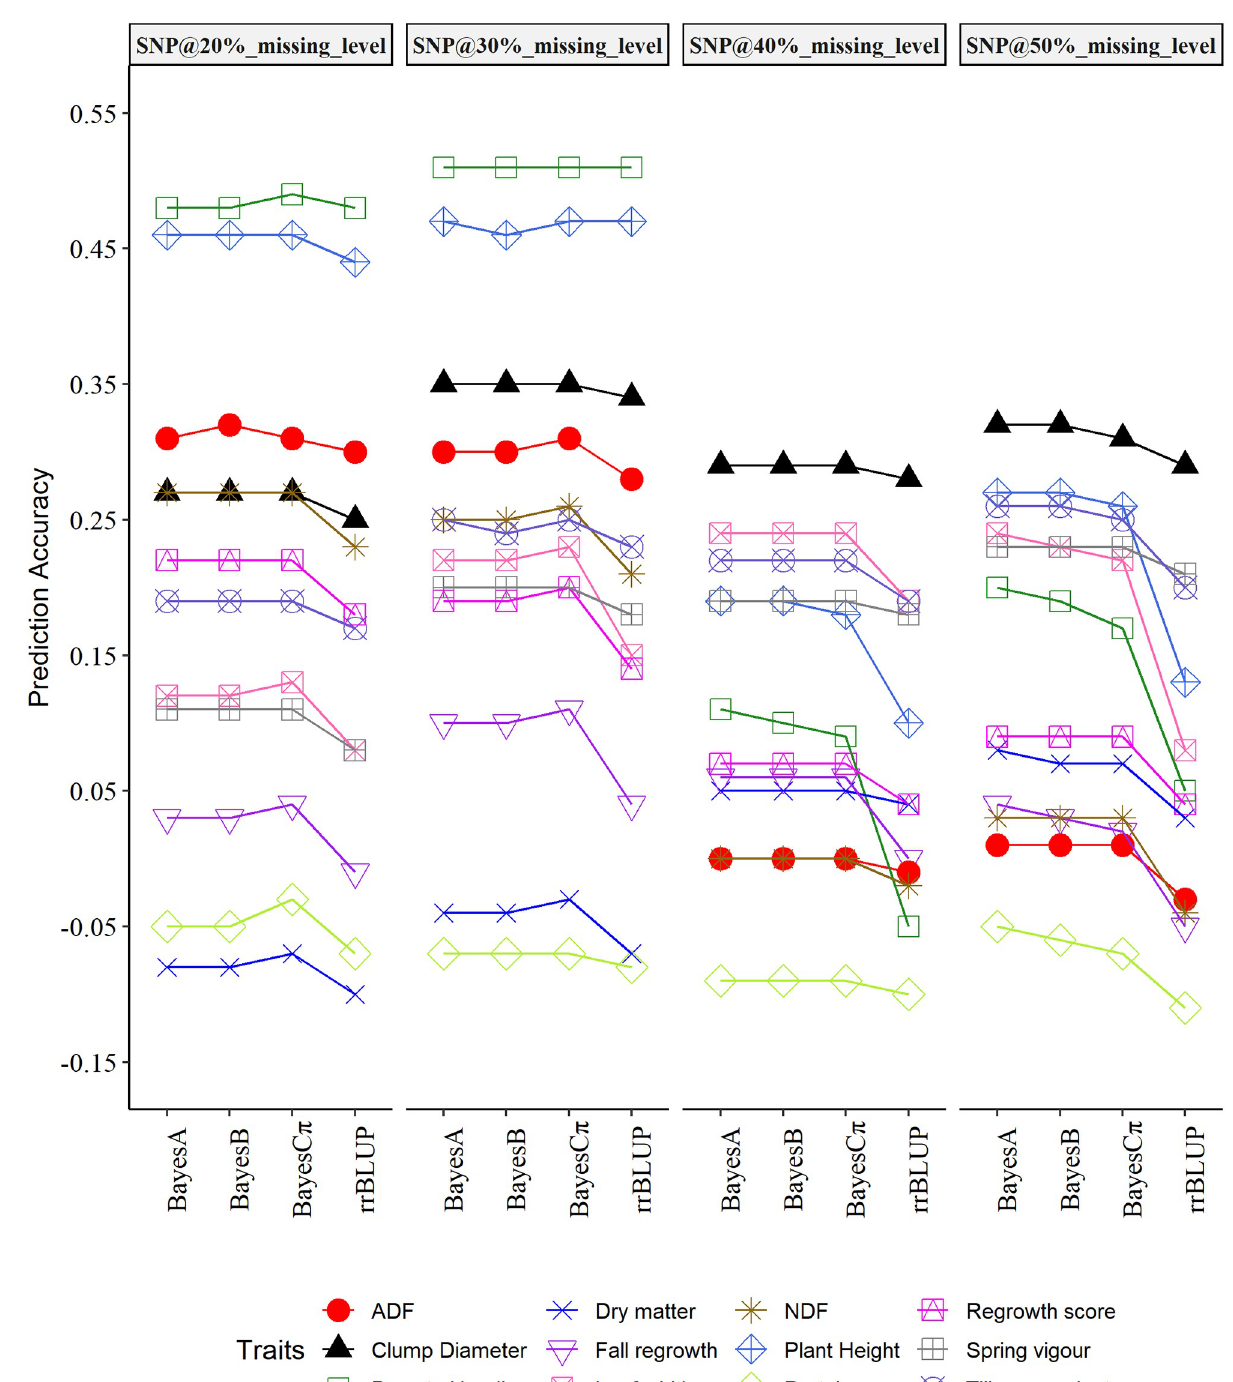
Fig 2. Prediction accuracy of four genomic selection models for genotypes evaluated at Saskatoon, Canada.